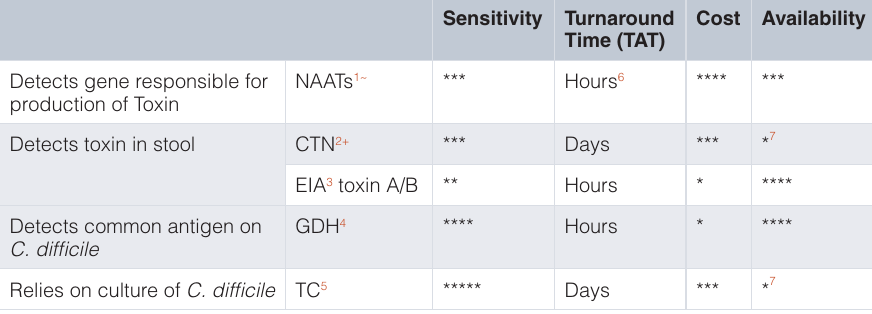
Table 1. Properties of tests available for C. difficile infection